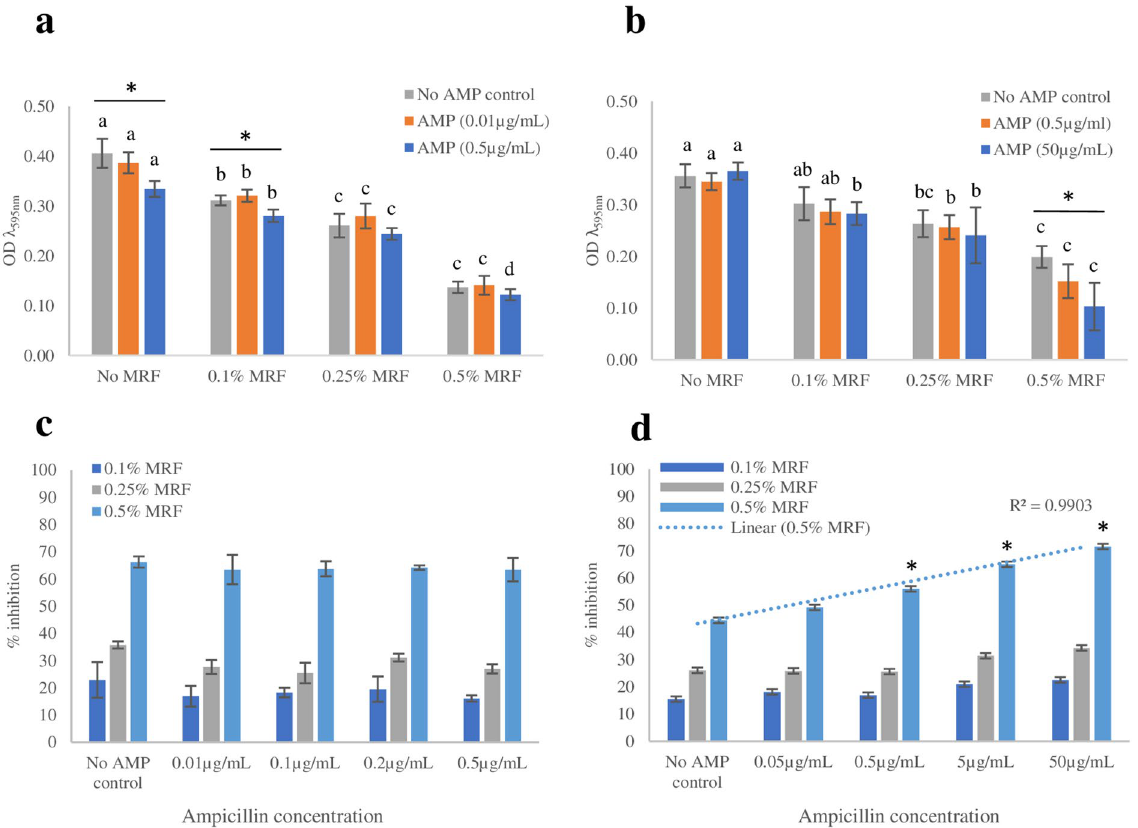
Figure 2. Effect of MRF supplementation on end-point* optical density (OD) and percentage inhibition; (a) Final OD of antibiotic susceptible E. coli ; (b) final OD of antibiotic resistant E. coli ; (c) percentage reduction of antibiotic susceptible E. coli resulting from MRF supplementation relative to no MRF supplementation; (d) percentage reduction of antibiotic resistant E. coli resulting from MRF supplementation relative to no MRF supplementation. Each value was expressed using mean of triplicate values for each biological replicate, standard deviation is represented by error bars. Means per AMP concentration that do not share a letter are significantly different to the corresponding ‘No MRF’ relative mean ( p ≤ 0.05, ANOVA, Fisher-LSD). Values marked with an asterisk [*] are significantly different to the ‘No AMP control’ treatment relative to the corresponding MRF concentration ( p ≤ 0.05, ANOVA, Fisher-LSD). *End-point = 18 h OD